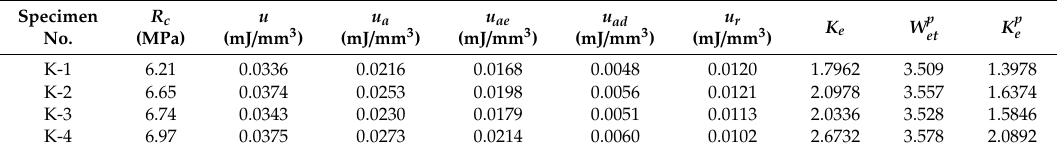
Table 4. Calculated energy parameters for the typical test